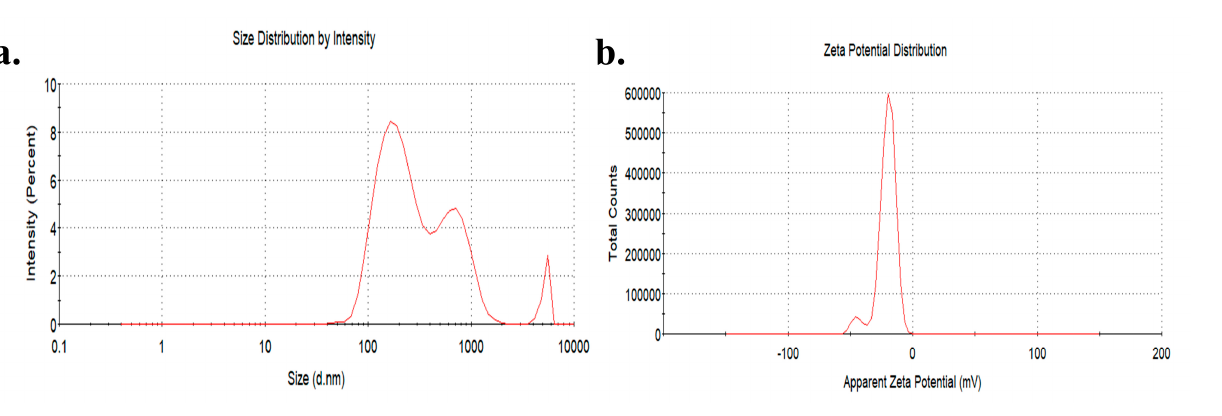
Figure 1. Distribution of hydration particle size ( a ) and zeta potential ( b ) of TiO 2 NPs in a serum- free medium.